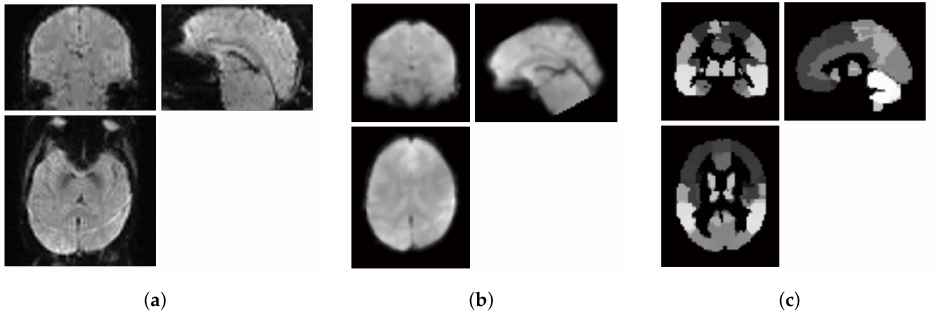
Figure 1. An example of normalization and registration of an fMRI image. ( a ) Original fMRI image of sub12855 in the Berlin_Margulies project; ( b ) normalized fMRI image; ( c ) registered fMRI image after normalization, where each color represents the clustered brain region.